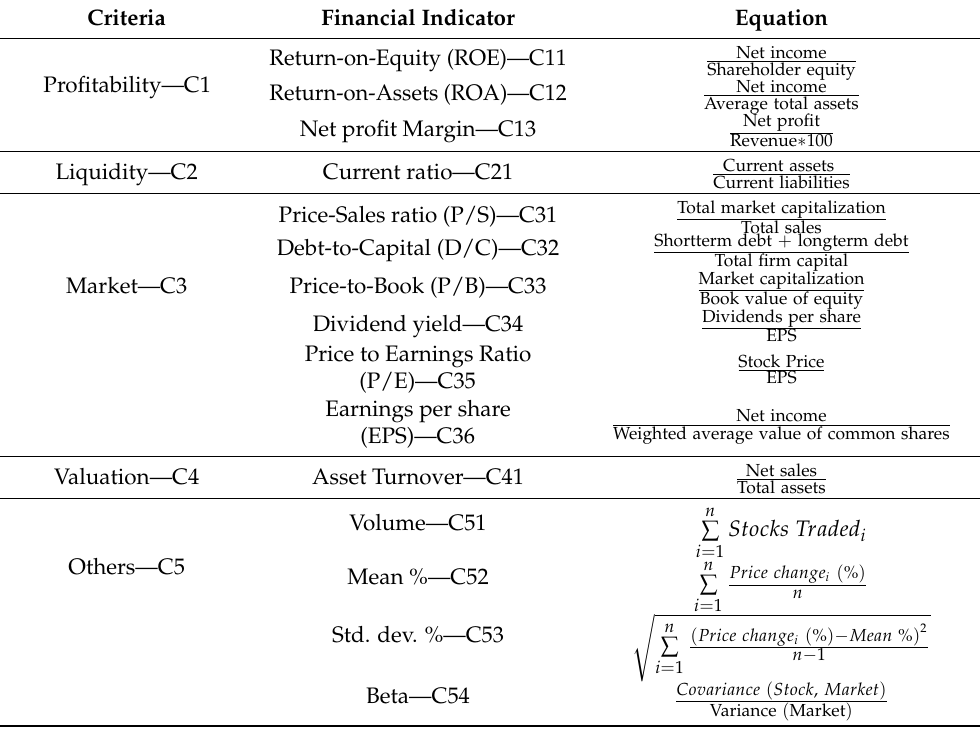
Table 1. Lists the most critical financial indicators in evaluating equities used in this